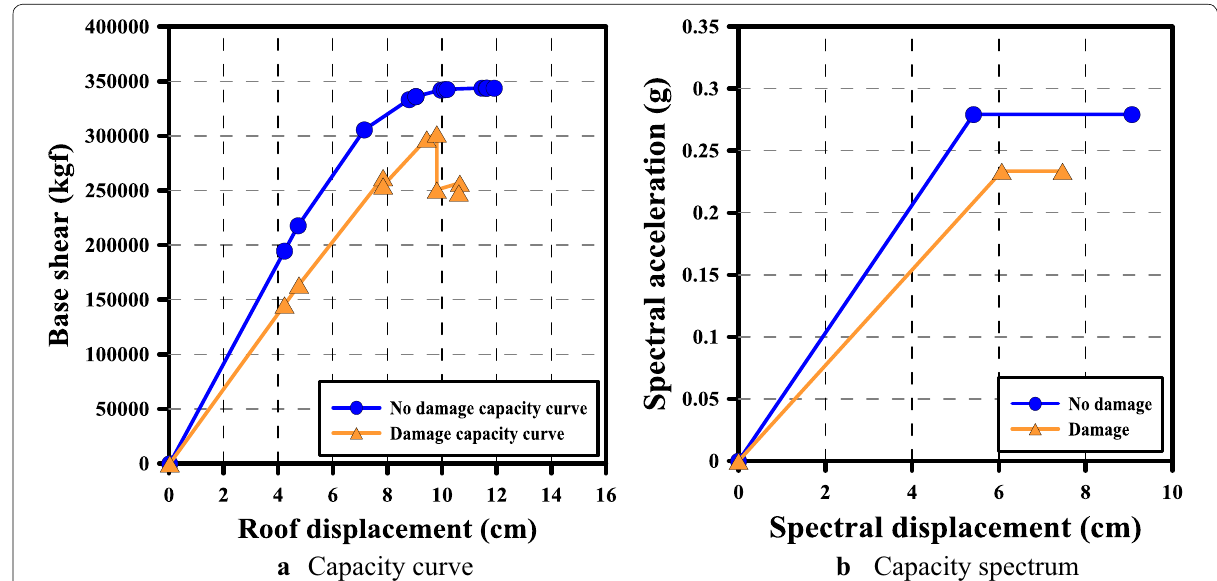
Fig. 24 Seismic performance of the selected building obtained using the pushover analysis.